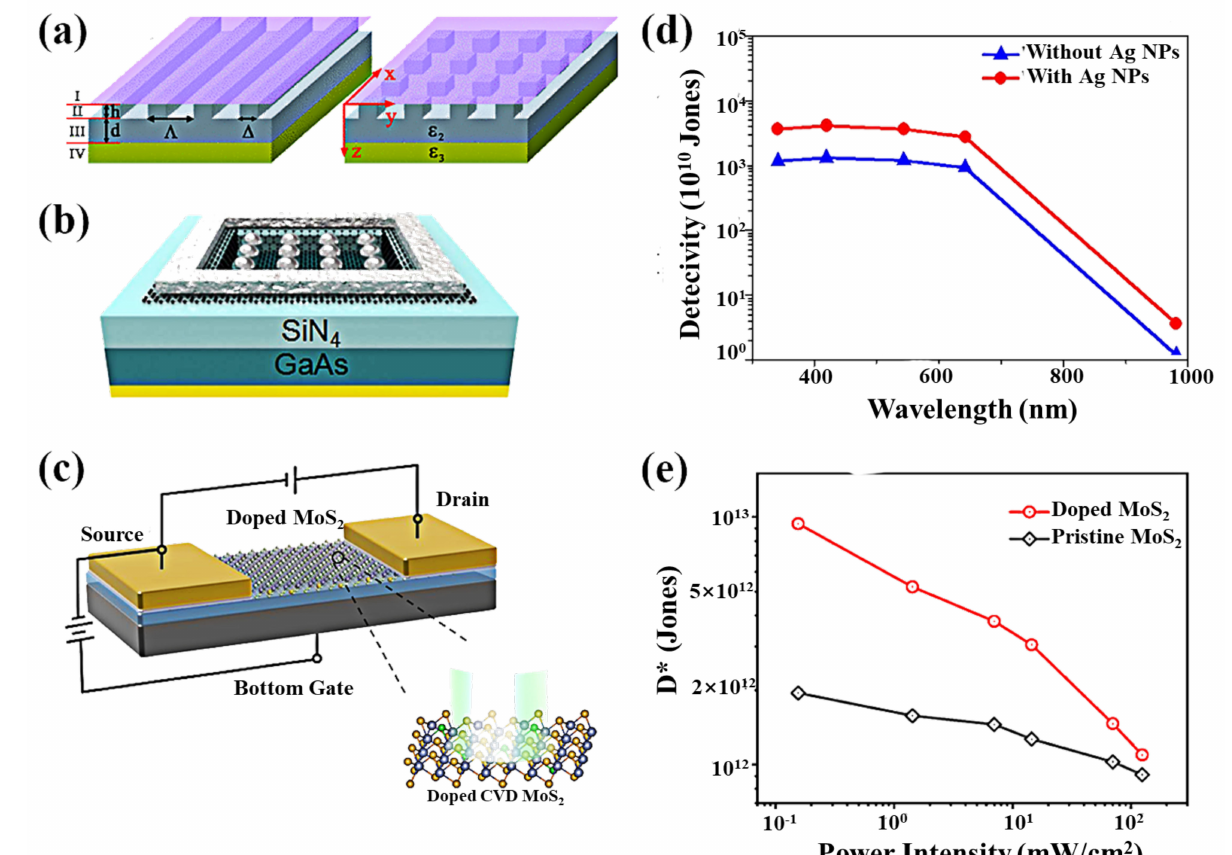
Figure 13. The 2D materials-based plasma photodetectors. ( a ) Schematic view of a graphene monolayer supported on a 1D and 2D SWDG with thickness h, period, and strip/cylinder size. ( b ) Schematic diagram of graphene/GaAs photodetector with AgNPs. ( c ) Schematic diagram of the structure for the doping CVD MoS 2 photodetector. ( d ) Detectivity of the graphene/GaAs photodetector with and without 100 nm AgNPs under zero bias voltage at five excitation wavelengths. ( e ) Power intensity dependence of D* for the two photodetectors. ( a ) Reproduced with permission from [161]. Copyright American Physical Society, 2012. ( b , d ) Reproduced with permission from [113]. Copyright Elsevier, 2018. ( c , e ) Reproduced with permission from [106]. Copyright American Chemical Society,